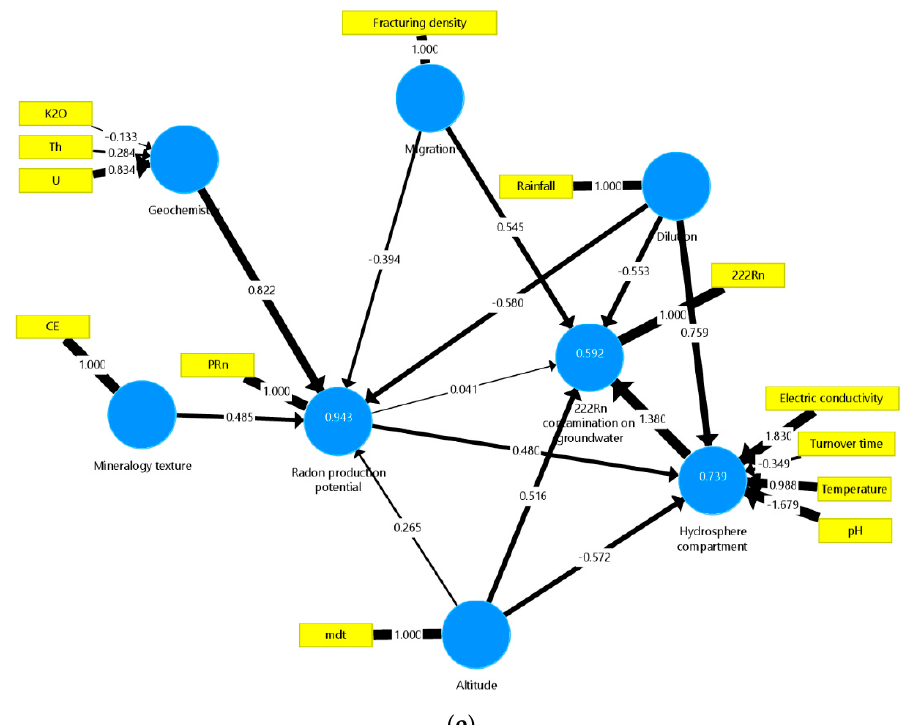
Figure 10. Diagrammatic representation of PLS-PM complete models for cluster C2 composed by different groups of rocks from the studied region: ( a ) Group C2a composed by metasediments (Group I), ( b ) Group C2b composed by two-mica granites with low-radon production (Group III), ( c ) Group C2c composed by two-mica ( d ) Group C2d1 composed by biotite granites with high-radon production (Group V), ( e ) Group C2d2 composed by biotite granites with high-radon production (Group V) with the addition of the hydraulic turnover time.